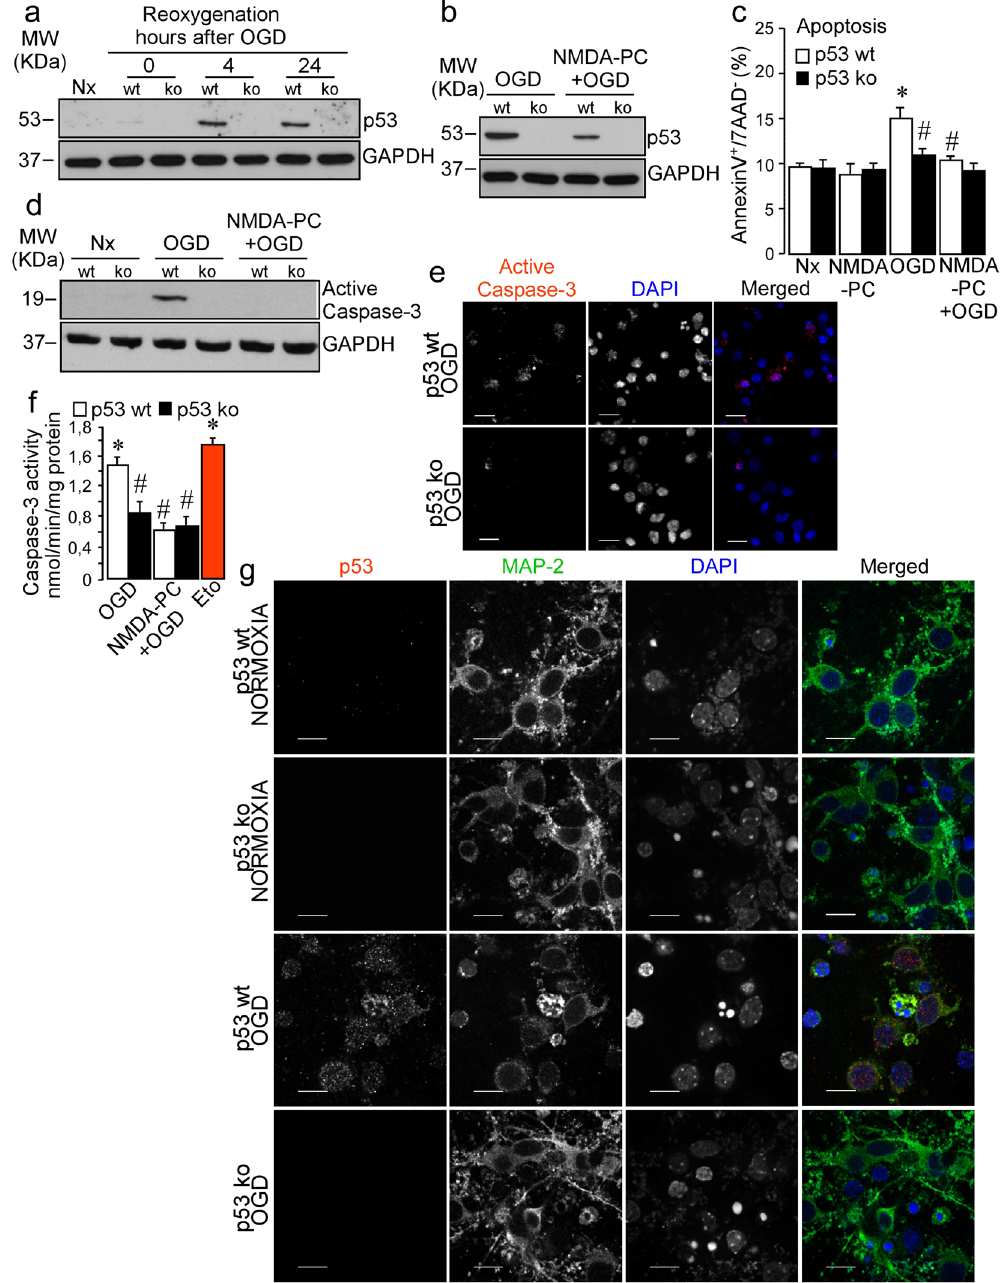
Figure 3. NMDA-PC prevents ischemia-induced neuronal apoptosis pathway mediated by p53. Cortical neurons from p53 wt or p53 ko mouse were exposed to a validated in vitro model of NMDA-PC (Table 1) and neuronal extracts were analyzed by western blotting. ( a ) At 4 hours after OGD, p53 stabilization was observed in wt, but not in p53 ko, neurons, ( b ) which was prevented by NMDA-PC. The lack of p53 totally prevented apoptosis caused by OGD at 4 hours after the ischemic insult, as revealed by ( c ) flow cytometry and active caspase-3 analyzed by ( d ) western blot, ( e ) immunofluorescence and ( f ) fluorimetry analysis. ( c ) The percentage of annexin V-APC stained neurons that were 7AAD negative were considered to be apoptotic (AnnexinV + /7AAD − ). GADPH protein levels were used as loading control. ( e ) Fluorescence microphotographs of both wt and ko neurons after immunostaining for active-Caspase-3 (red). Scale bar: 20 μ m. ( g ) immunostaining for p53 (red) and Map-2 (green). Scale bar: 15 μ m. Data are means ± S.E.M. (n = 3 independent neuronal cultures). Statistical analysis of the results was evaluated by one-way analysis of variance, followed by the least significant difference multiple range test. Student’s t-test was used for comparisons between two groups of values. In all cases, p < 0.05 was considered significant. * p < 0.05 versus Nx. # p < 0.05 versus OGD. Relative percentages of neurons with protein-staining are presented in Supplementary Fig. S1. Relative protein abundances quantification Fig. 3a, Fig. 3b,d are presented in Supplementary Fig. S2, the “full-length blots/gels are presented in Supplementary Fig. S3 and that Nx controls are shown in Fig.